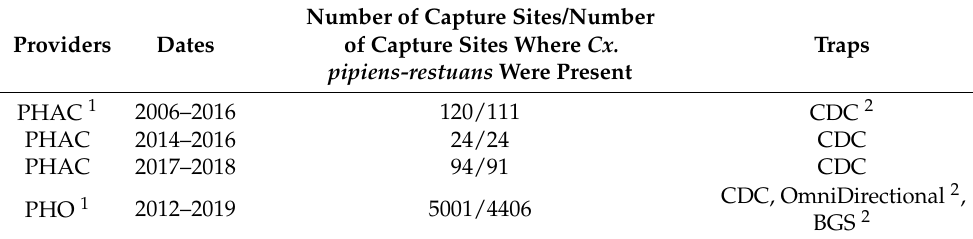
Table 1. Mosquito capture